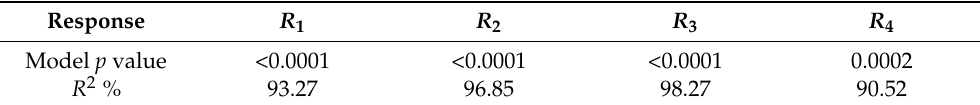
Table 6. ANVOA analysis.